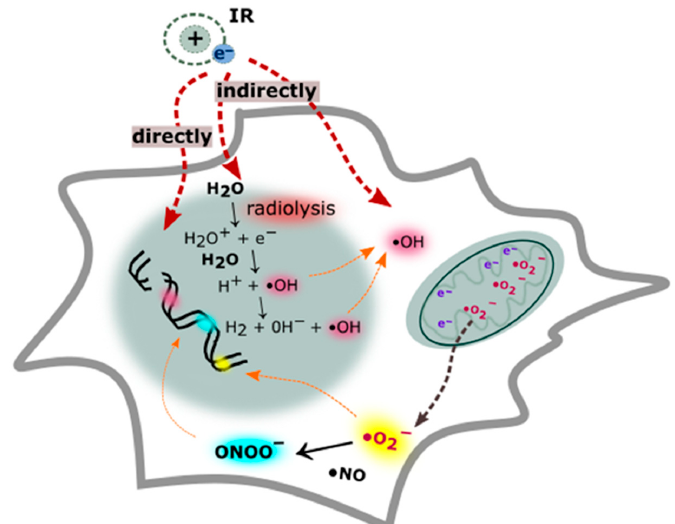
Figure 2. Direct and indirect formation of DNA damage. The absorption of ionizing radiation by living cell hits the DNA molecule directly and disrupts the chemical structure of the DNA double helix. The indirect effect of ionization depends on the radiolysis of cellular water and cellular component disruption. The removal of an electron from water leads to alterations in the nuclear and mitochondrial genome via the overproduction of reactive oxygen species (ROS) and reactive nitrogen species (RNS). During ionizing radiation (IR) exposure, large amounts of nitric oxide (•NO) are generated, which is relatively unreactive and, together with superoxide (O2 • − ), they form a peroxynitrite anion (ONOO − )—a powerful oxidant.